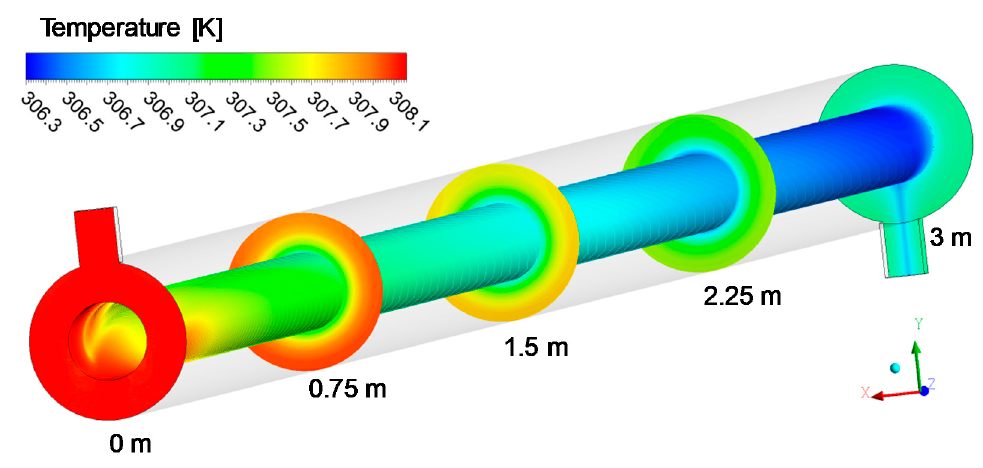
Figure 9. Temperature field inside the shell and tube module for T 0 = 35 °C (Case 5).